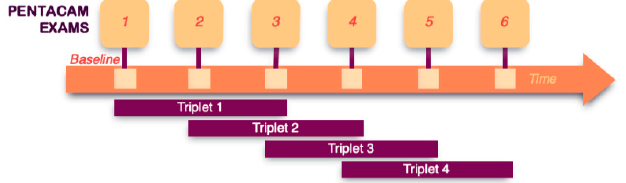
Figure 1. Triplets of consecutive measurements to maximize data availability. Data maximization was performed, creating triplets of consecutive measurements for those eyes with more than 3 examinations. The triplets were classified as no errors whether all the measurements were marked as OK by the Pentacam software. For triplets with error, only 1 measurement was allowed to be of less quality (marked yellow by Pentacam).